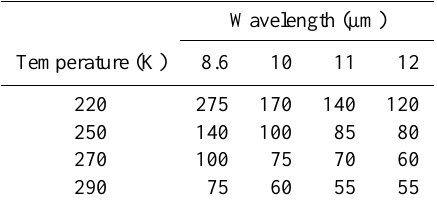
Table 2. Theoretical NE 1T ’s (mK) for four narrow-band channels of the thermal infrared imaging camera and for four different scene